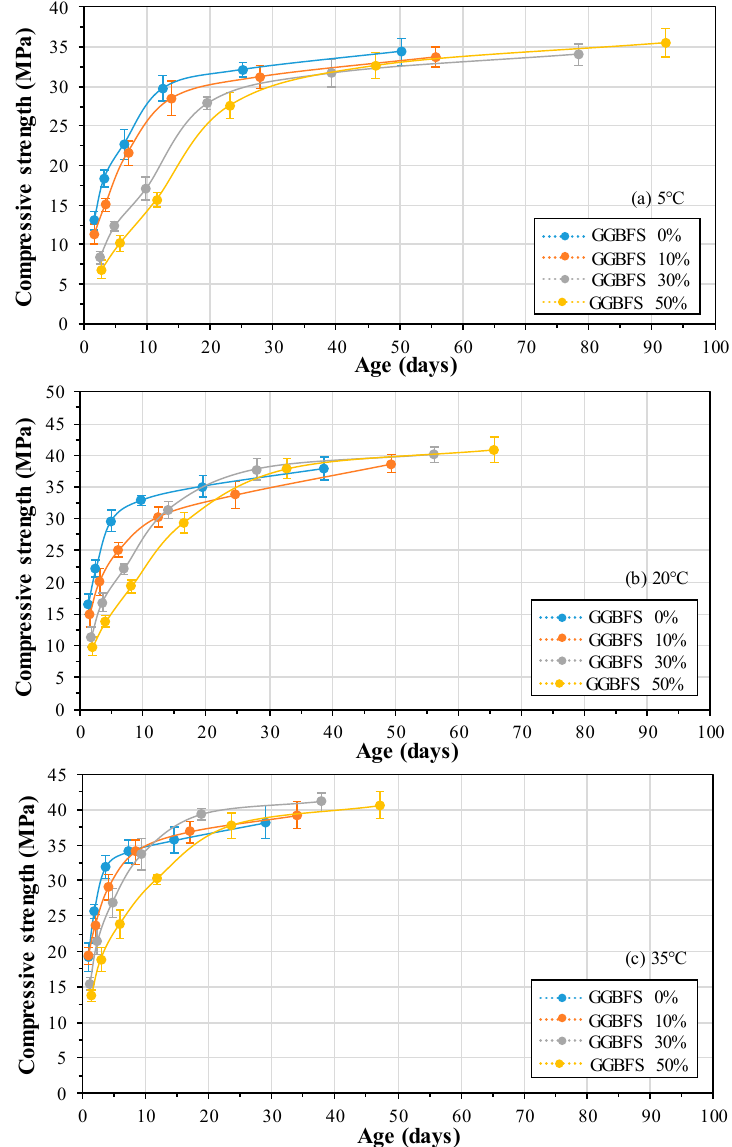
Figure 3. Compressive strength of mortar, according to curing temperature and replacement ratio of GGBFS ( a ) 5 °C, ( b ) 20 °C, ( c ) 35 °C.